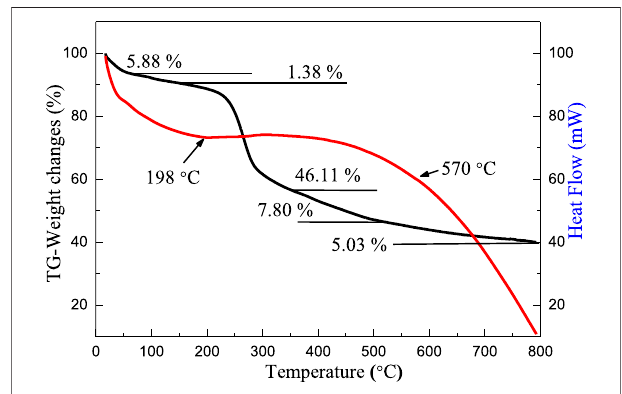
FIGURE 1 | TG – DSC curves of precursors of MoS 2 /C composites with the concentrations of molybdenum chloride of 0.20 mol/L prepared by the hydrothermal calcination